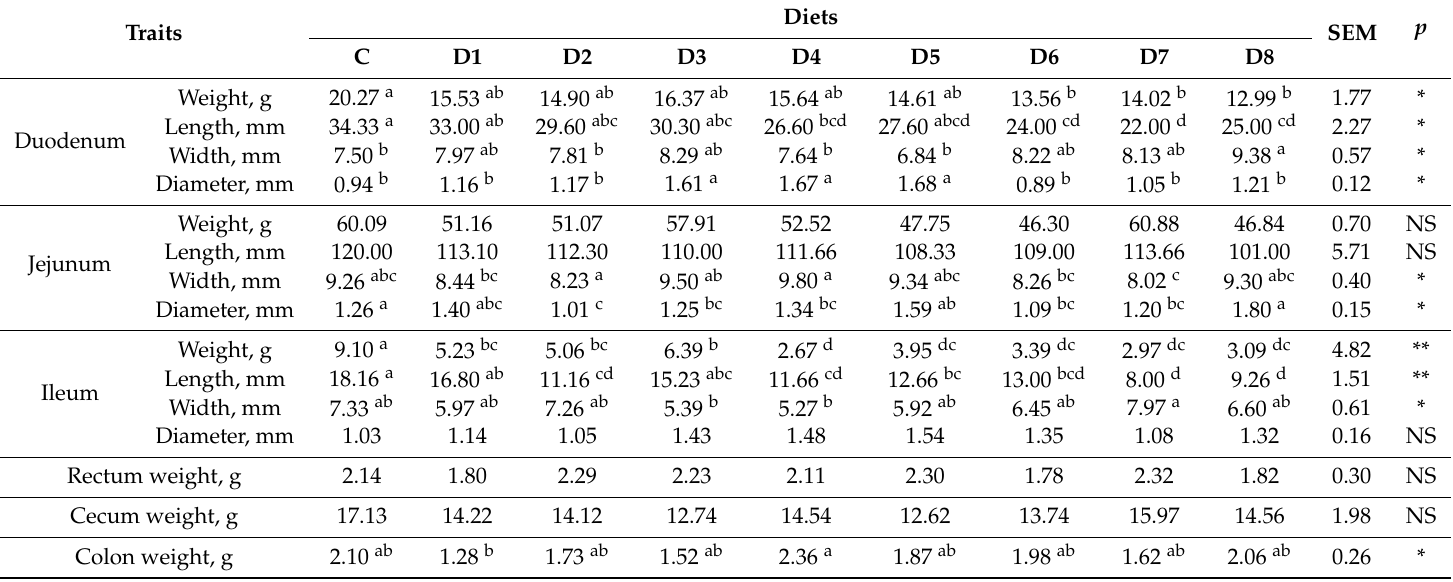
Table 5. Ross 308 broilers’ intestine segment dimensions according to feed diets from 1–6 weeks of